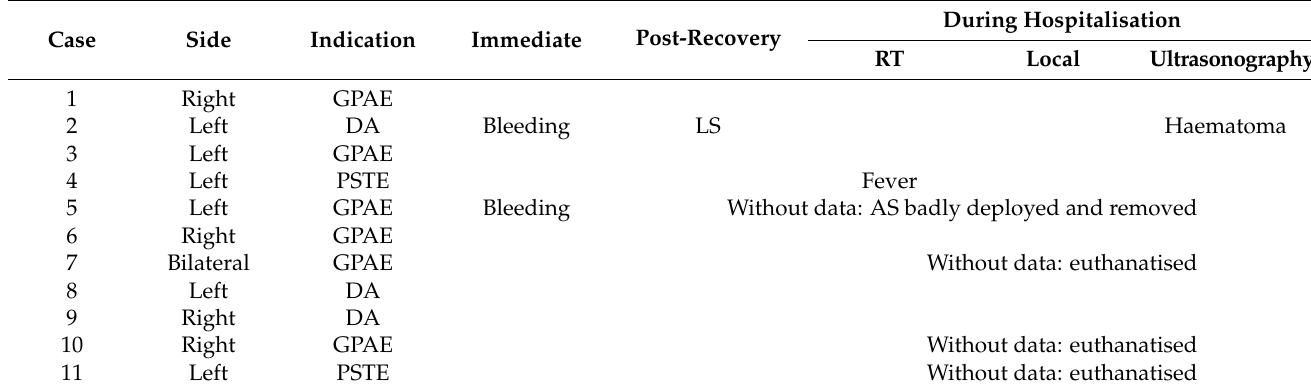
Table 1. Access side, indication and findings registered after the